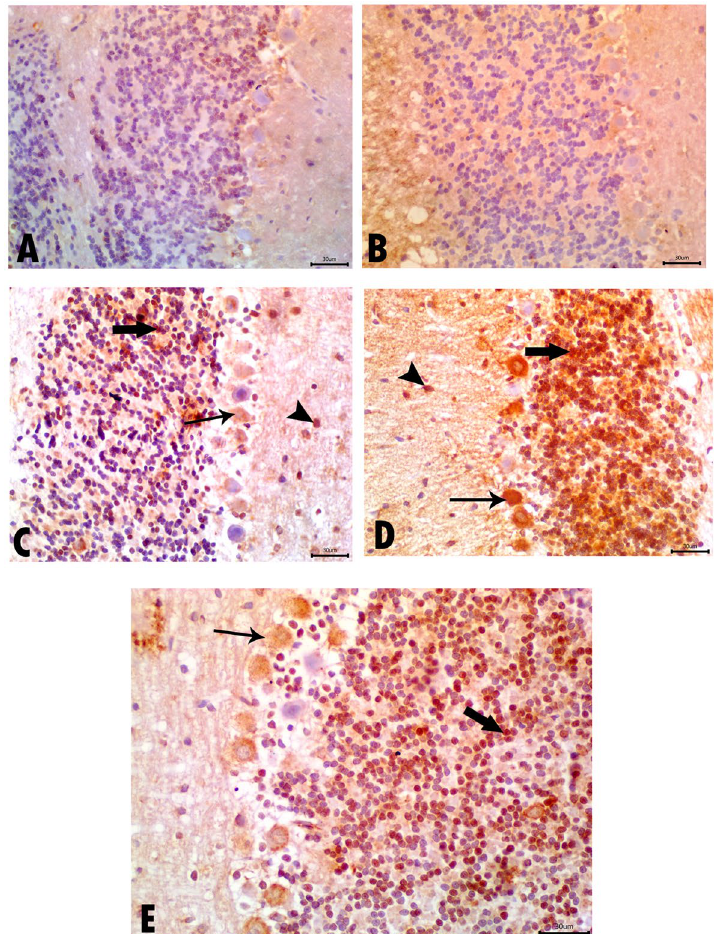
Fig. 5 Photomicrographs of sections in the cerebellar cortex immunohistochemically stained with caspase-3 ( positive control groups show negative caspase-3 immunoreaction in cytoplasm and nuclei of cells in granular, molecular, and Purkinje cell layers. C Acute treated group shows few positive reactions in cells of granular (thick arrow), molecular (arrowhead), and Purkinje cell layers (arrow). D Chronic treated group reveals strong positive reaction in cells of granular (thick arrow), molecular (arrowhead), and Purkinje cell layers (arrow). E Chronic withdrawal group shows weak immunoreactivity in cells of granular (thick arrow) and Purkinje cell layers (arrow) compared to the chronic